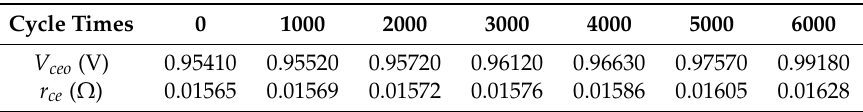
Table 4. The V ceo and r ce under different aging states.